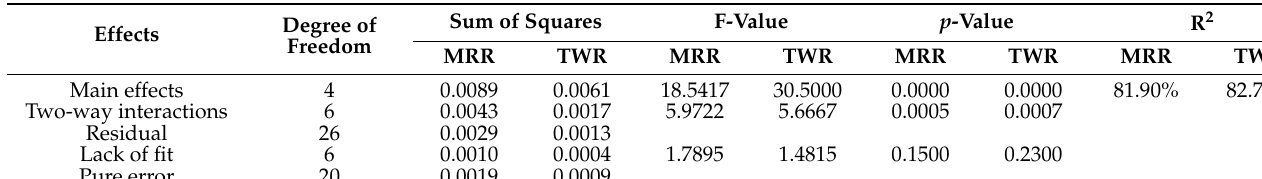
Table 2. The two-way ANOVA results.